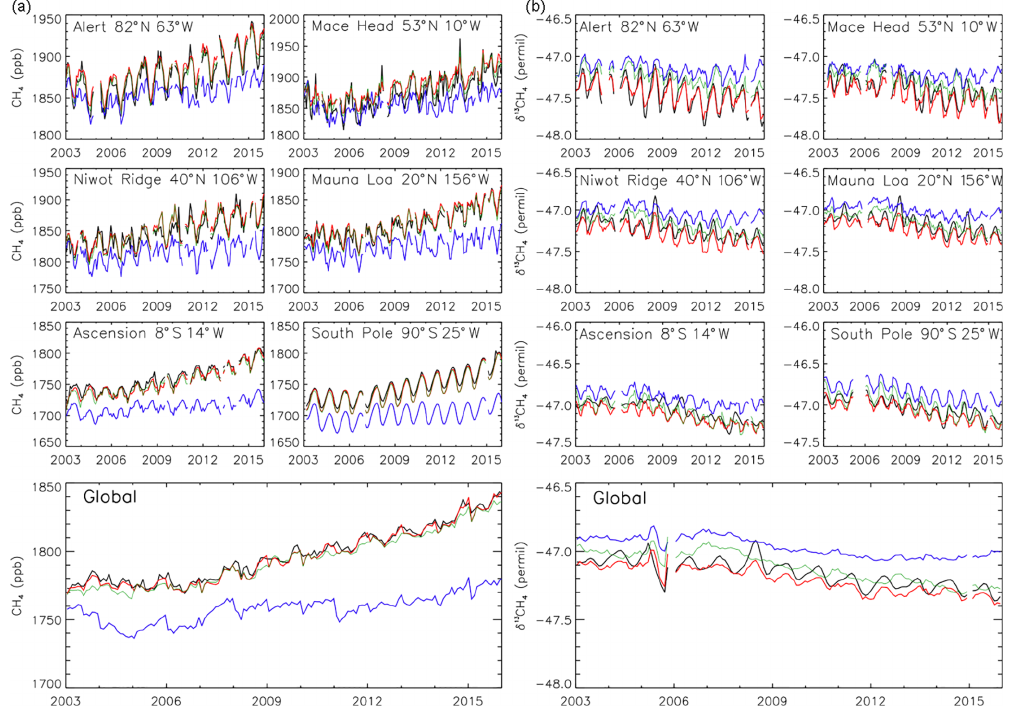
Figure 1. (a) Observed surface CH 4 (ppb, black line) from 2003 to 2015 at six selected NOAA sites and global mean. Also shown are results from TOMCAT simulations using prior emissions estimates (blue line), posterior estimates based on a CH 4 synthesis inversion (INV-CH4, green line), and posterior estimates based on a combined CH 4 and δ 13 CH 4 synthesis inversion (INV-FULL, red line). (b) Same as (a) but for observed and modelled δ 13 CH 4 . Global averages are based on site interpolations onto 180 1 ◦ latitude bins, which are weighted by surface area.